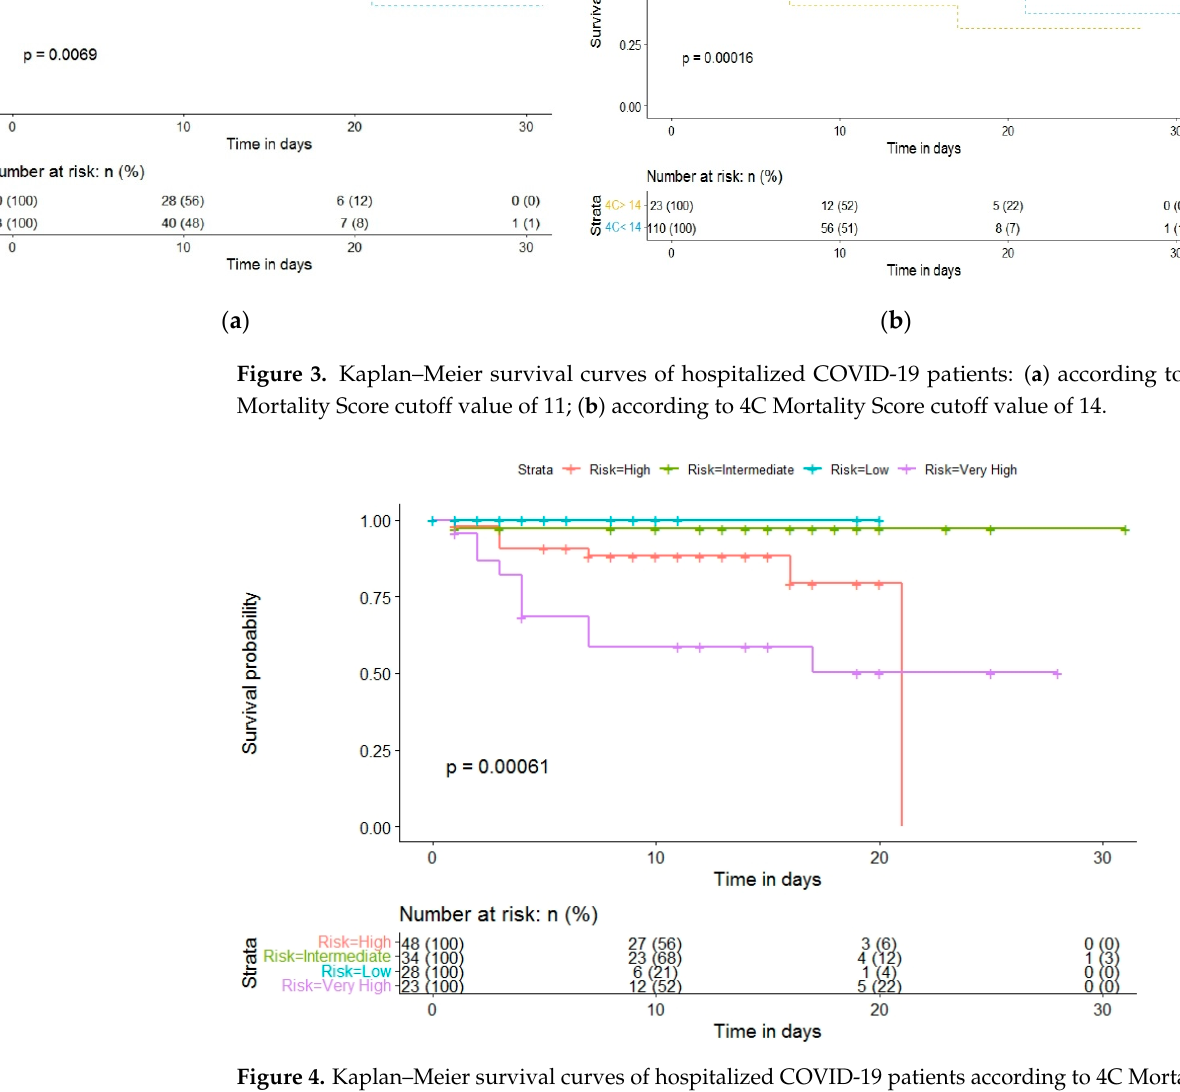
Figure 4. Kaplan–Meier survival curves of hospitalized COVID-19 patients according to 4C Mortality Score risk.